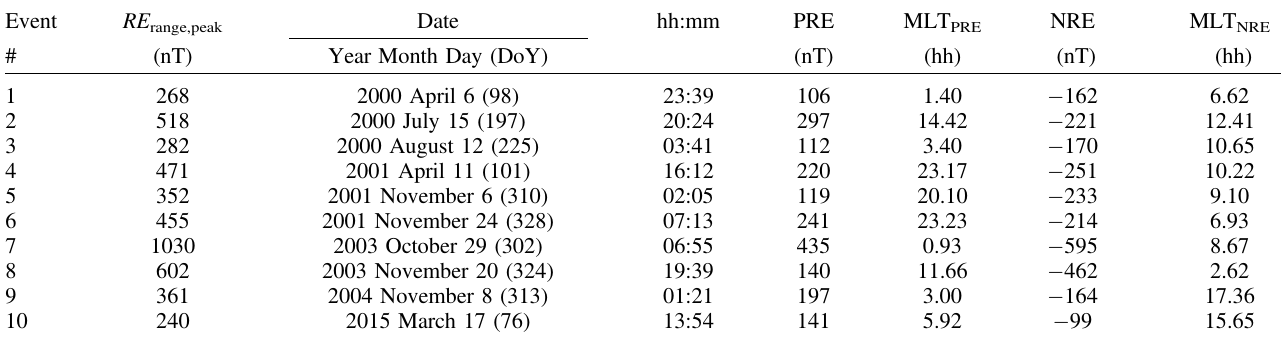
Table 4. Summary of the results for the events analysed. The table includes: the peak value reached by the RE range (column 2) for the event (column 1), the date (UT) when the peak value of RE range is reached (column 3), the Positive and Negative Residual Envelopes (PRE and NRE) at that date (columns 4 and 6) and the MLT at the observatory whose R obs ,i coincides with the PRE and NRE at the date in column (3). Event RE